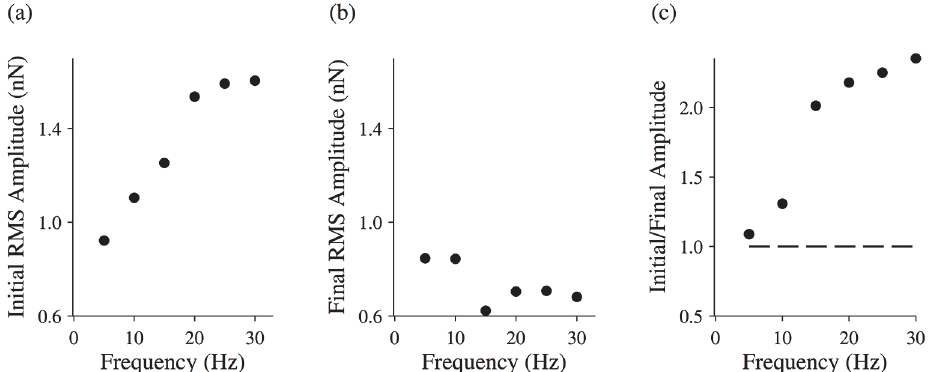
Fig 11. Changing force response for a simulated half-sarcomere. The root-mean-squared (RMS) amplitude for the initial driving oscillation (a) and the final driving oscillation (b) for a simulated half- sarcomere. (c) The ratio of the initial and final RMS amplitudes for a simulated half-sarcomere. The total length of the oscillation was 2 seconds.